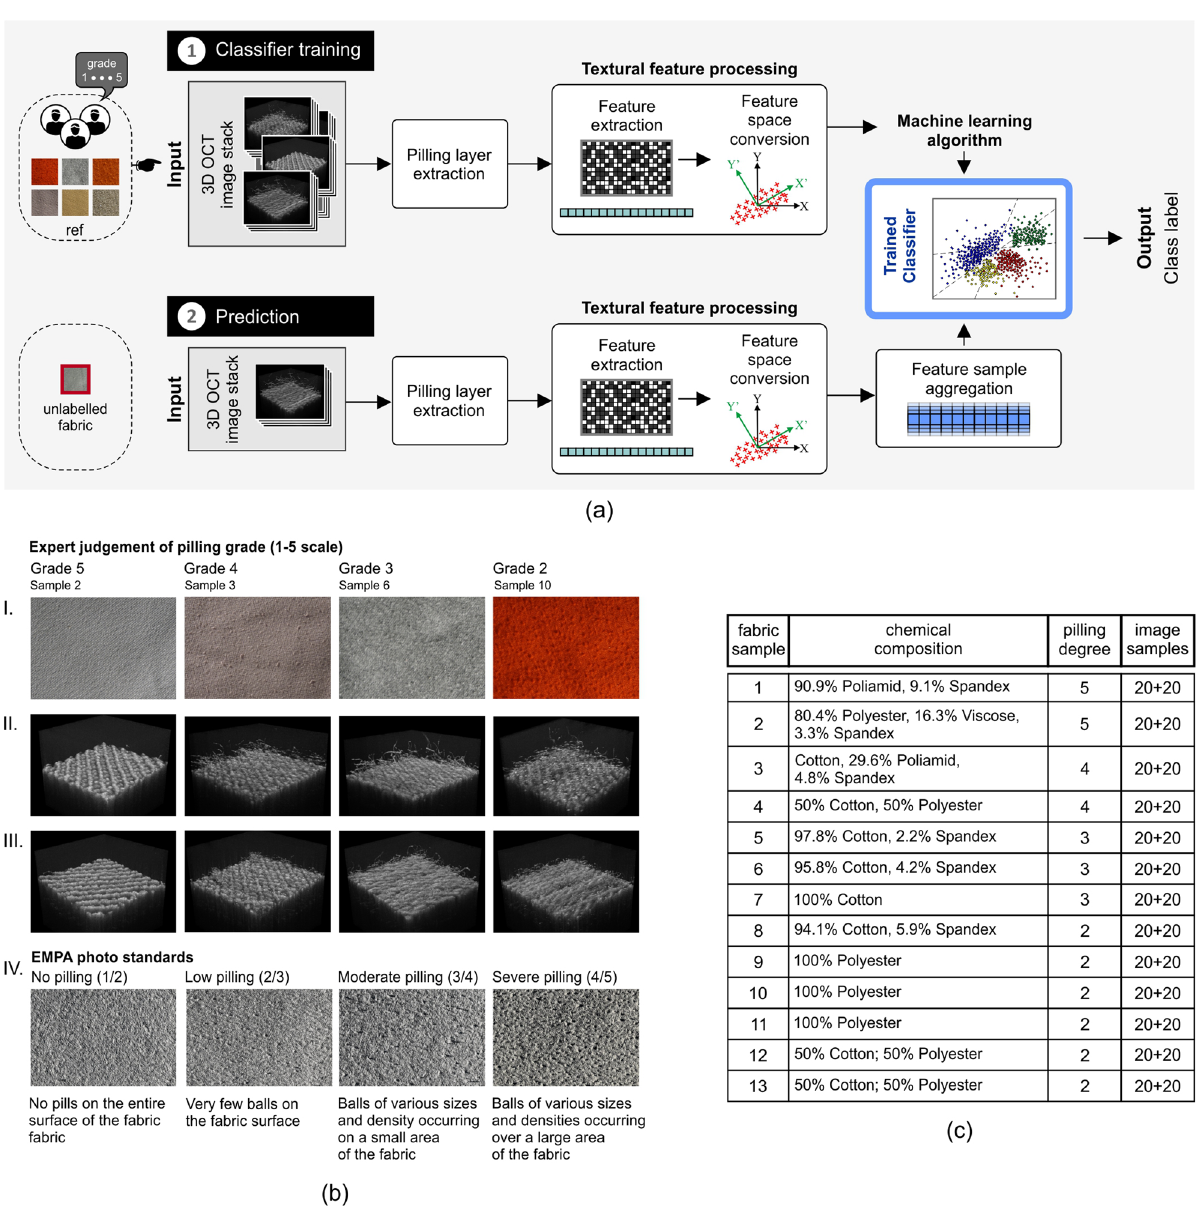
Figure 1. Illustration of the proposed method for assessing pilling resistance. Textural features associated with pilling behavior are extracted from OCT volumetric scans. Pilling tendency is evaluated using PLS-DA, LDA, and SVM classification methods. To predict the degree of pilling, a virtual sample of each fabric is introduced, with the features averaged from images taken of a single fabric ( a ). The entire test set of scans consists of fabrics with pilling symptoms of various degrees of severity ( b ) and chemical compositions ( c ). Pilling grades are given by experts on the basis of the EMPA photographic standard for textiles, No. SN 198525. The images in rows II and III from subset ( b ) illustrate the surfaces of exemplary fabrics with different pilling classes, visible in OCT images after custom and Martindale abrasion tests, After the machine test T2, in the case of fabrics with a tendency to pilling, OCT images may contain fewer individual fibers than after the manual test, but usually contain additional structures of fibers clumped together (Fig. 1b, row III). The proposed system of assessing pilling resistance aims to capture these differences in terms of the textural features. In both paths shown in Fig. 1a the pilling layer is extracted from the OCT volumetric images using the Pilling layer extraction module, detailed in “Extraction of the pilling layer from an OCT fabric image” section. It enables selection of the pilling region only, without the fabric layer below it. Textural feature processing block performs the calculations of pilling image textural characteristics such as Haralick 30 or fractal features 31 and image lacunarity properties 32 . This is described in detail in “Extraction of textural features” section. After the extraction of features they are cleaned of outliers, scaled (“Extraction of textural features” section) and before the classification reduced to the limited number of mutually independent components as the Feature space